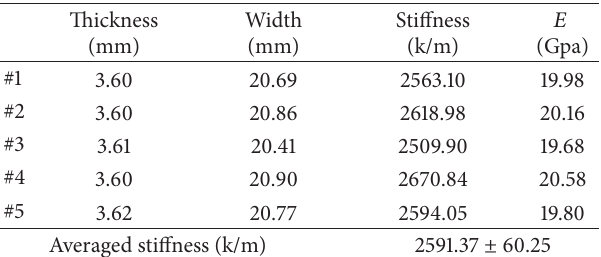
Table 6: Specifications of the half-circular composite leg made by the E-glass (0 ∘ , 90 ∘ )-0 ∘